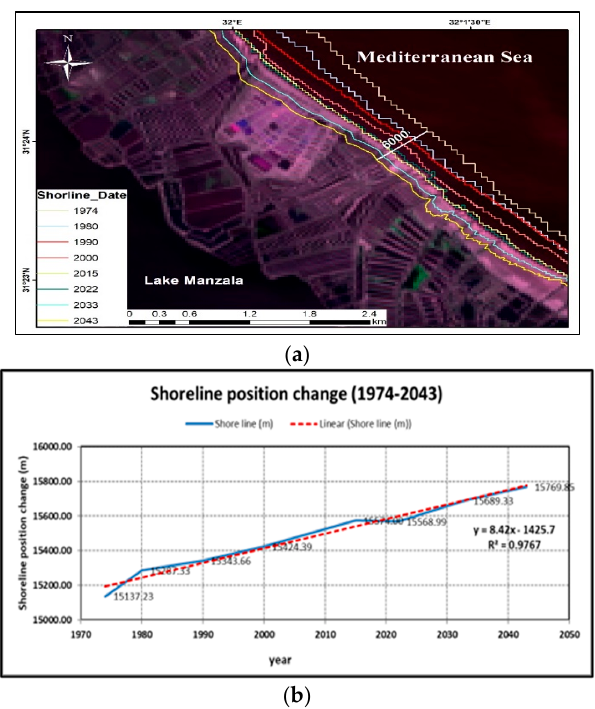
Figure 10. Shoreline changes over time at Lake Manzala (1974–2043): ( a ) shoreline change at Lake Manzala, ( b ) time series of changing the shoreline position at transect 6000.